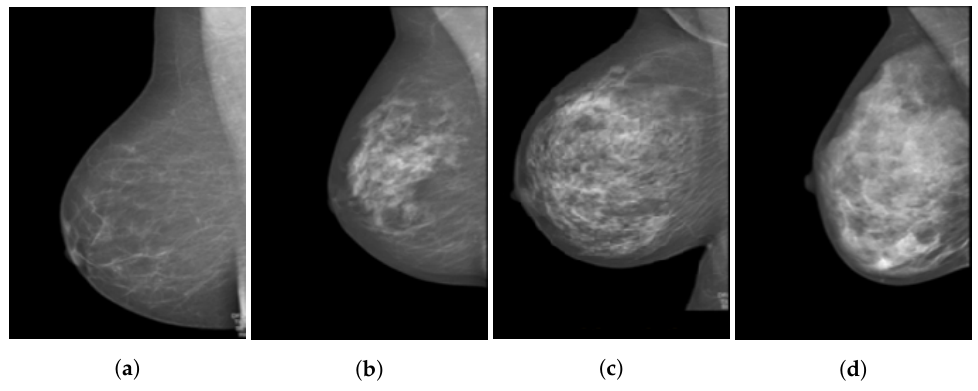
Figure 2. Sagittal cross-section of breast MRI scans showing the breast density variations: ( a ) almost entirely fat, ( b ) scattered fibroglandular tissue, ( c ) heterogeneous fibroglandular tissue, and ( d ) extreme fibroglandular tissue. Images from